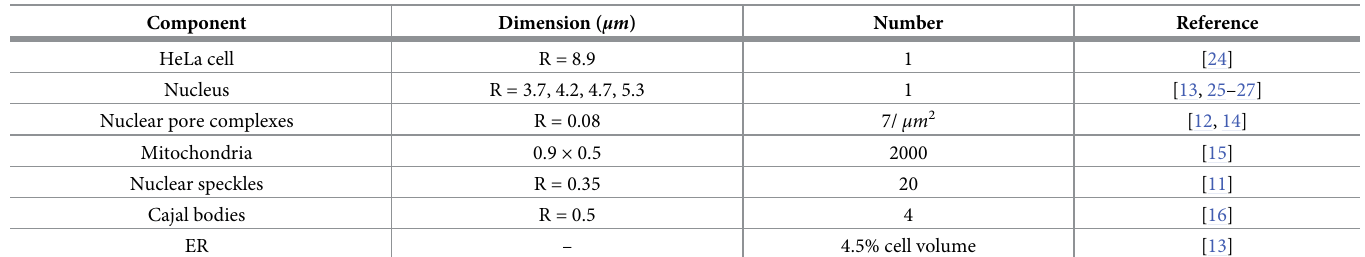
Table 1. The cellular components of the constructed HeLa